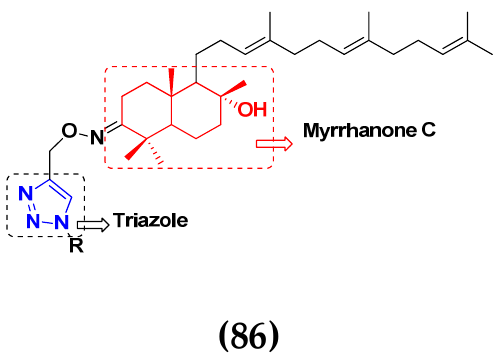
Figure 83. Structure of triazole–myrrhanore C derivatives ( 86 ). Table 72. In vitro cytotoxic activities of triazole –myrrhanore C hybrid compounds 86 ( a – c ).